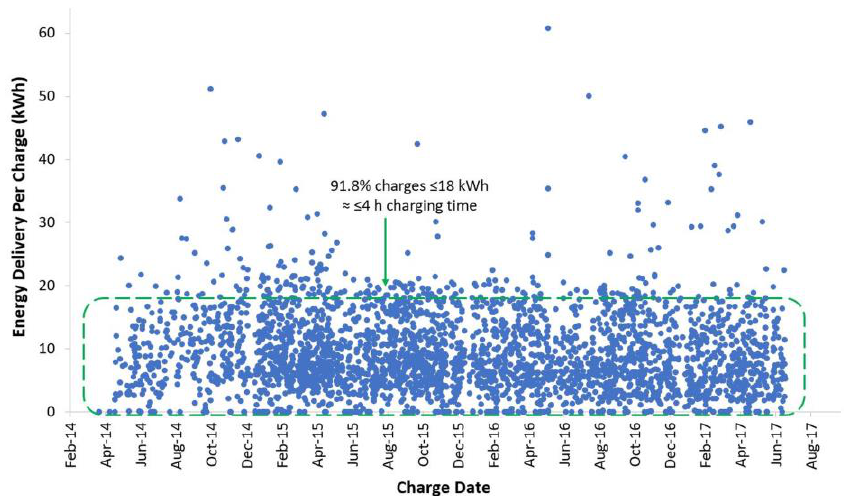
Figure 3. Scatterplot of energy delivery for each charging event.